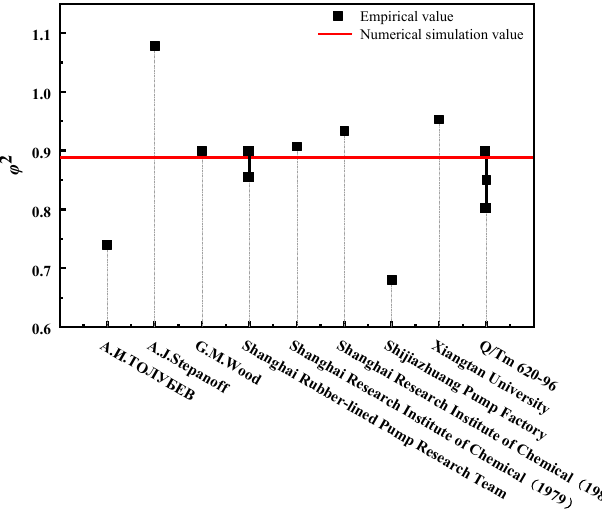
Figure 16. Comparison of the pressurization coefficient.